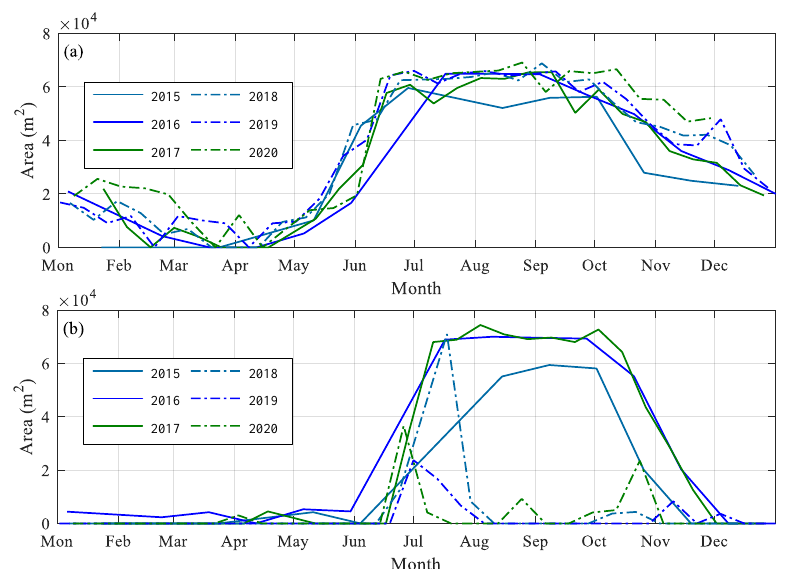
Figure 8. ( a ) and ( b ) show the annual water area changes of the XGL and DGL between 2015 and 2020, respectively. The curves corresponding to each year are superimposed for visual comparison. Table 1. Annual largest storage area and corresponding date statistics for DGL and XGL from 2015 to 2020. The variation is calculated by subtracting the area of the two adjacent years. XGL DGL